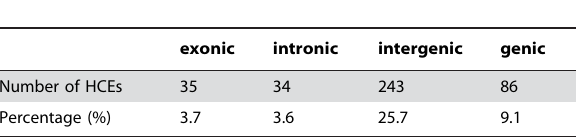
Table 5. The number of HCEs with consistent genomic location in the six